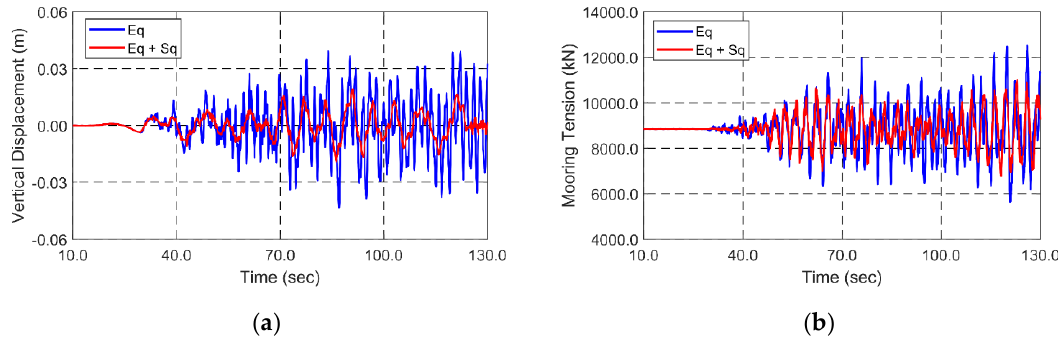
Figure 15. Time histories of vertical responses of the tunnel ( a ) and mooring tension #4 ( b ) in the middle location under seismic excitations with and without seaquake effect. Table 4. Statistics of the SFT motions and mooring tensions at the middle location under irregular seismic excitations (Eq: earthquake, Sq: seaquake).